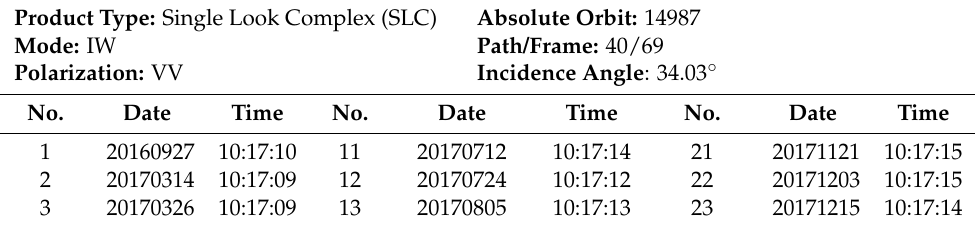
Table 2. Basic information and list of ascending Sentinel-1A Dataset II in LJP. The master image for PS and DS processing is 20170910.